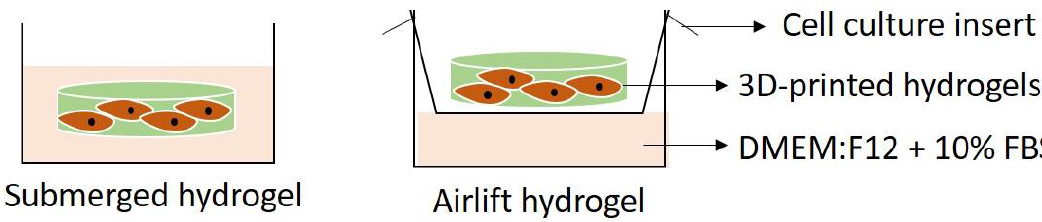
Figure 7. Pictorial representation of the submerge and airlift models used for the biocompatibility testing.